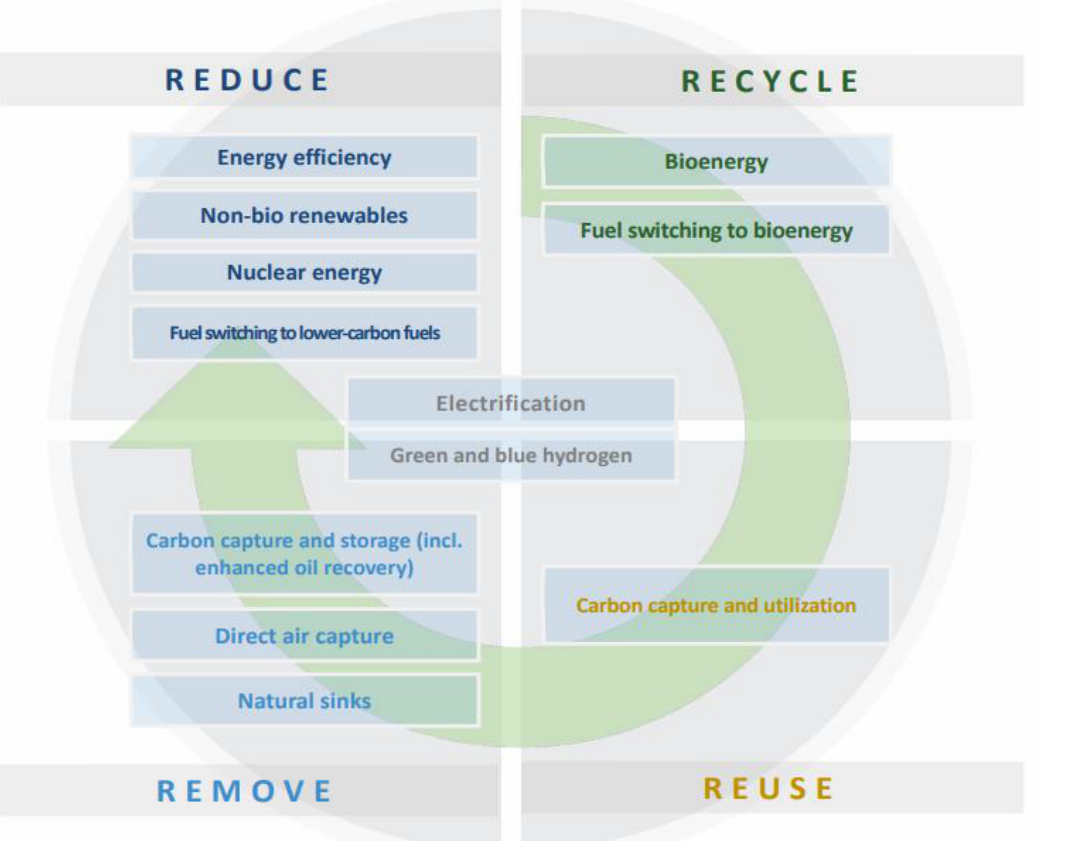
Figure 2. Circular carbon economy